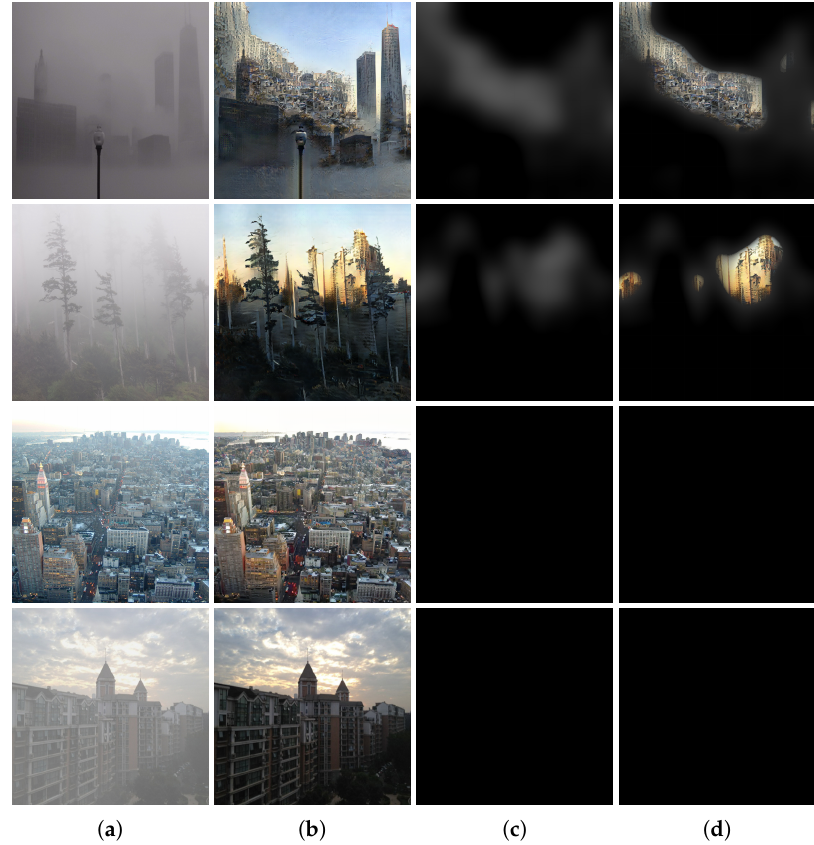
Figure 4. Some examples of the region detected by the HArD metric using real and synthetic images with different levels of inserted artifacts. The first two lines refer to real images with a heavy introduction of artifacts. The third row shows a real image with a very low insertion of artifacts. The last row includes a synthetic foggy image and the corresponding ground truth. ( a ) Foggy images ( b ) Defogged images ( c ) The regions where the HArD metrics detected the presence of artifacts, and ( d ) the regions of detected artifacts superimposed on the defogged image. Images are better viewed if enlarged on a computer